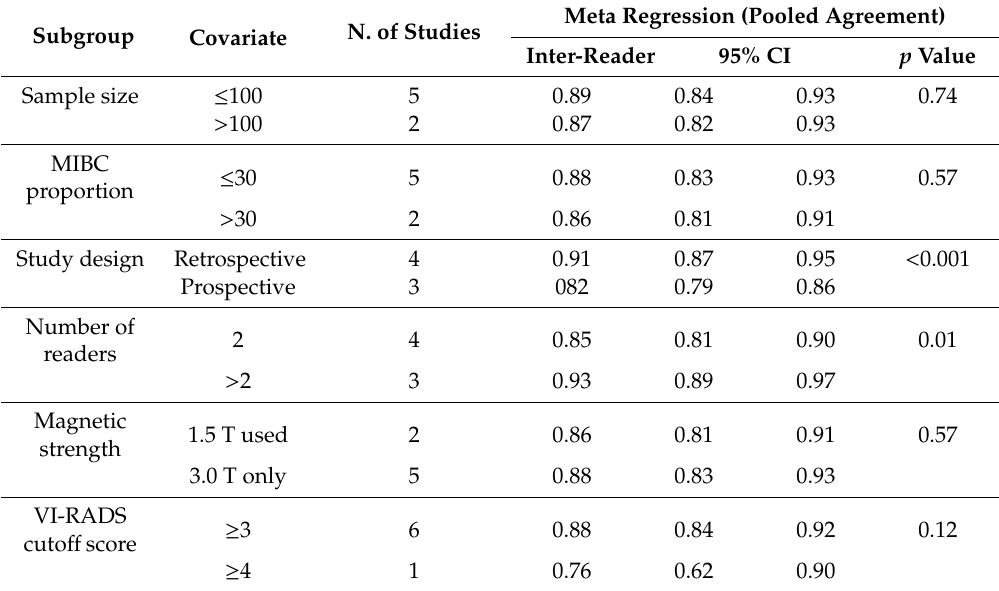
Table 3. Meta-regression analysis according to subgroup stratification; CI, Confidence